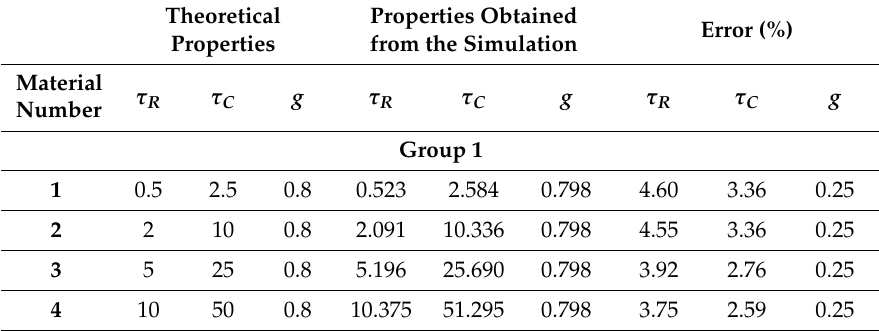
Table 1. Comparison between the values of properties set in ABAQUS and the ones obtained from the